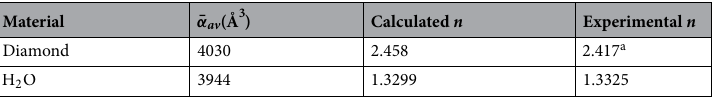
a Values from Ref. 43 . Experimental refractive indices are at a